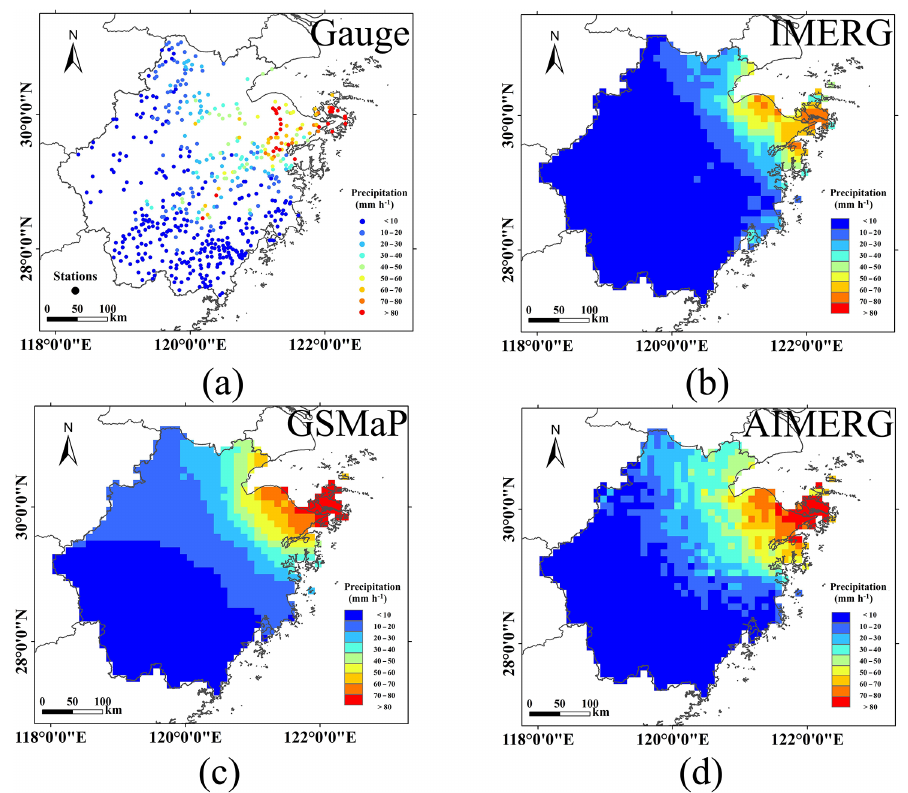
Figure 11. The spatial patterns of precipitation measured by (a) IMERG, (b) GSMaP, and (c) AIMERG during the typhoon, Chan-hom, which occurred in the typical period 00:00–11:00 on 11 July 2015 in the Zhejiang province. For visualization, the spatial maps were generated using ArcGIS 10.3 (http://www.esri.com/software/arcgis/).